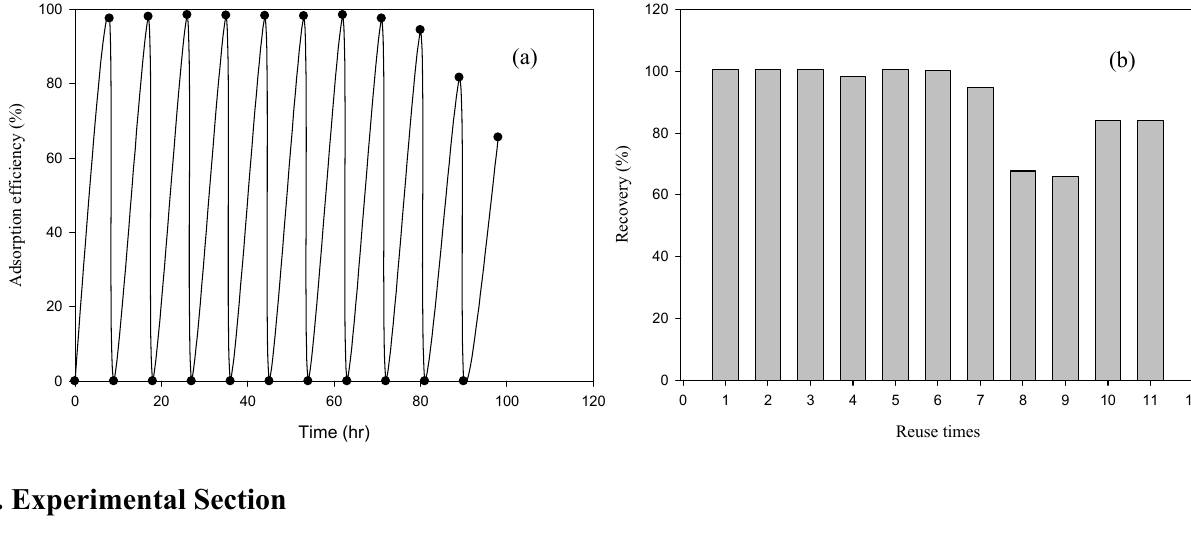
Figure 8. Multi-cycle adsorption-desorption experiments. ( a ) The adsorption efficiency of regenerated MNP-Tu for Au(III) adsorption; ( b ) The recovery efficiency of Au(III) from the Au(III)-loaded regenerated